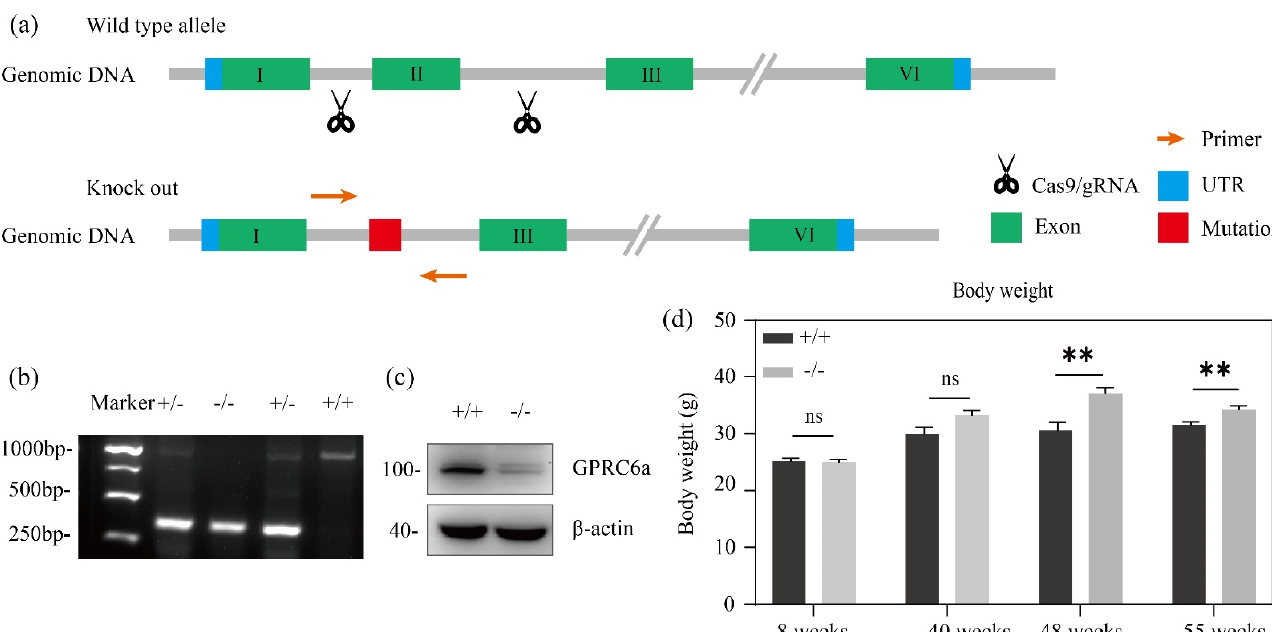
Figure 1. Schematic diagram of gene deletion sites, genotyping and body weight of GPRC6A − / − mice. ( a ) Schematic diagram of gene deletion sites. ( b ) Mice genotyping by PCR and electrophoresis. ( c ) Immunoblotting of protein extracted from mice liver. ( d ) Body weight of GPRC6A +/+ and GPRC6A − / − aged 8–55 weeks. +/+ represent WT, +/ − represent heterozygote and − / − represent KO, the data are shown as the means ± SE. ns, nonsignificant, p > 0.05. ** p < 0.01, n = 8–28.